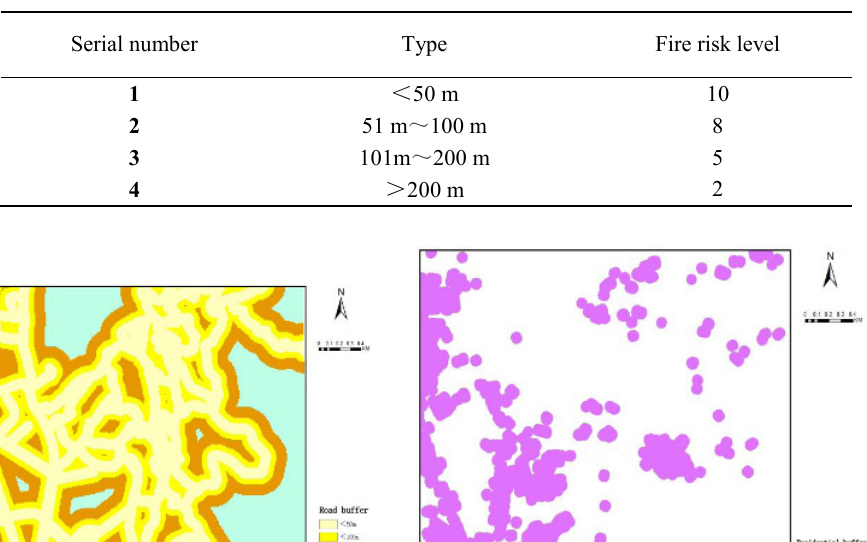
Table 3. Buffer factor fire risk rating table.